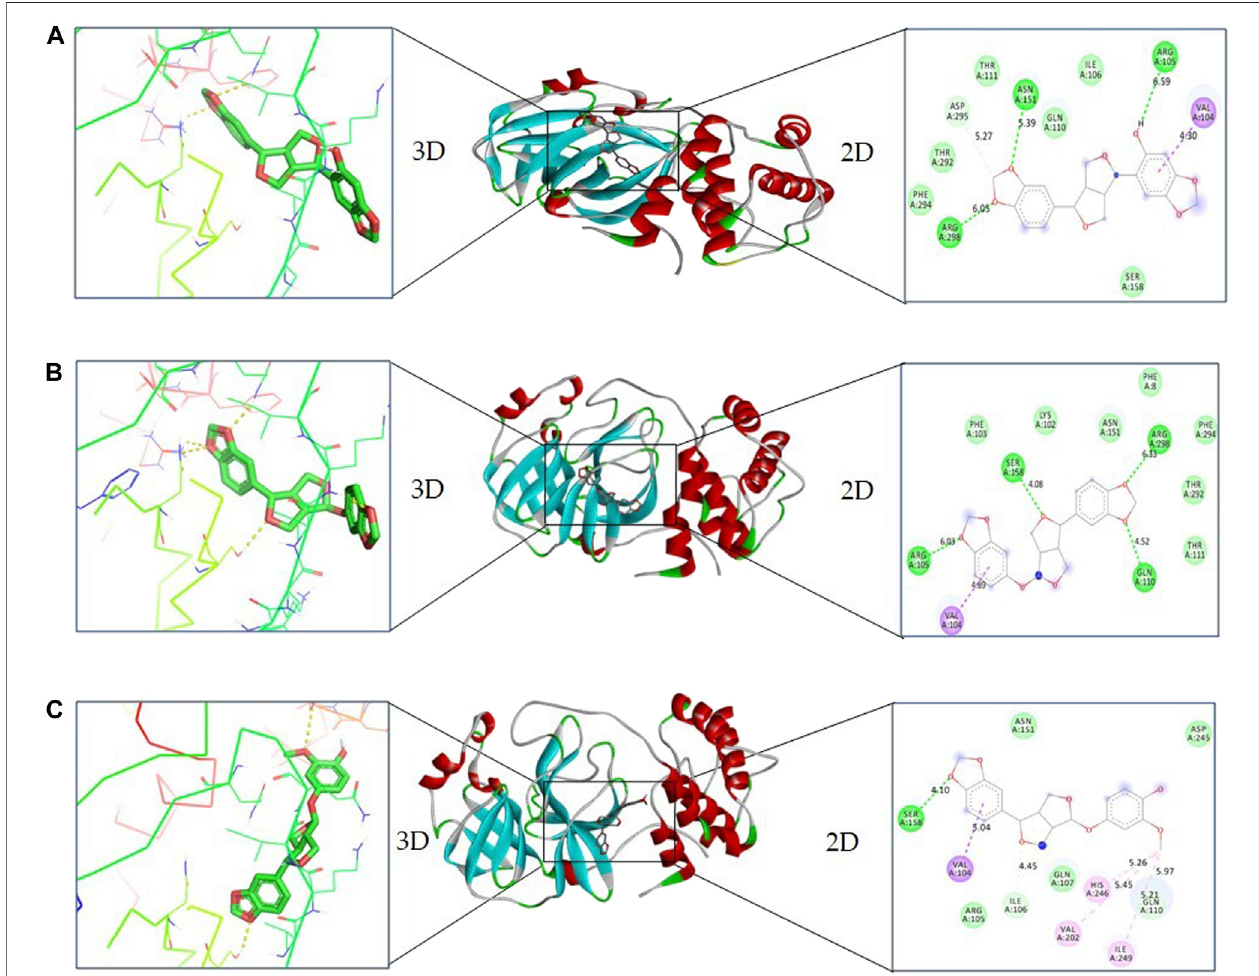
FIGURE 3 | 2D and 3D representation of docking complexes: (A) M pro and sesaminol complex; (B) M pro and sesamolin complex; (C) M pro and sesamolinol complex visualized using UCSF Chimera and Discovery Studio.